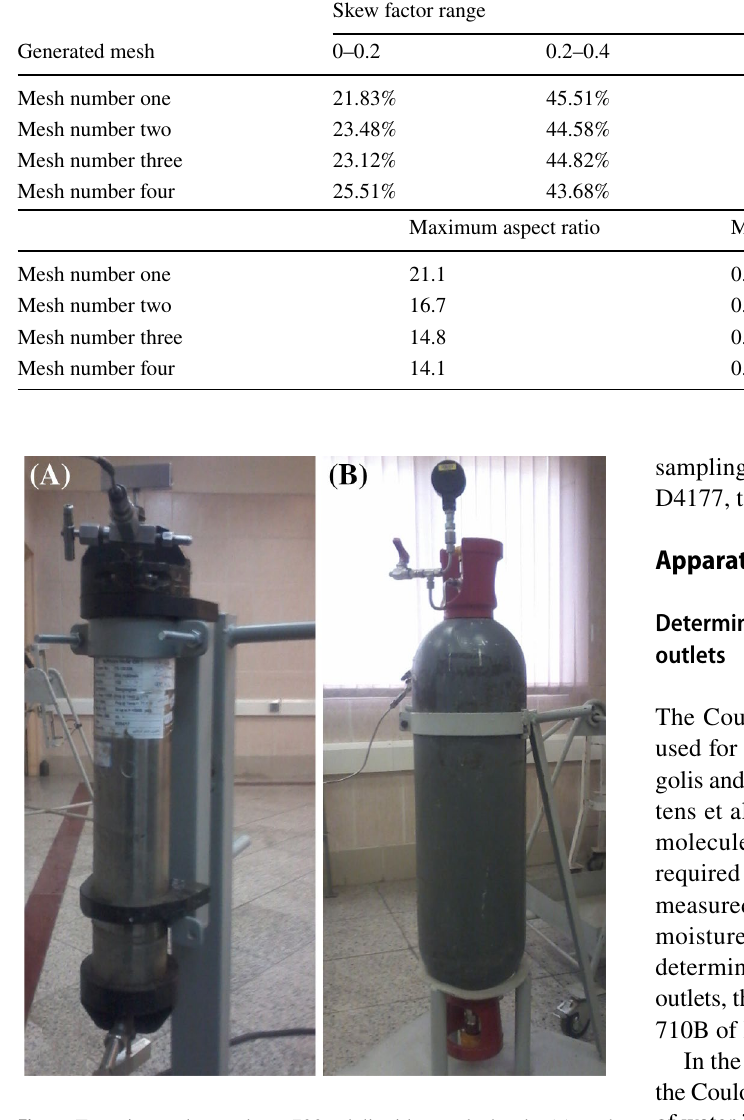
Fig. 4 Experimental samplers: 700-ml liquid sample bottle ( a ) and 20,000-ml high-pressure gas sample cylinder ( b